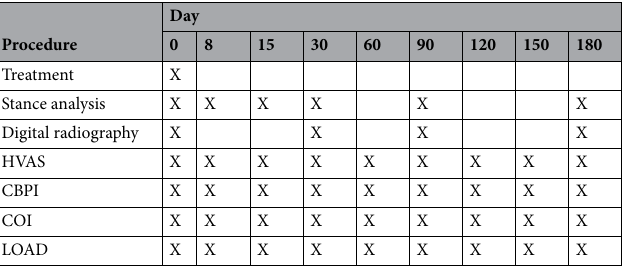
Table 4. Procedures conducted in each evaluation moment. Days are counted from treatment day. CBPI Canine Brief Pain Inventory, COI Canine Orthopedic Index, HVAS Hudson Visual Analogue Scale, LOAD Liverpool Osteoarthritis in